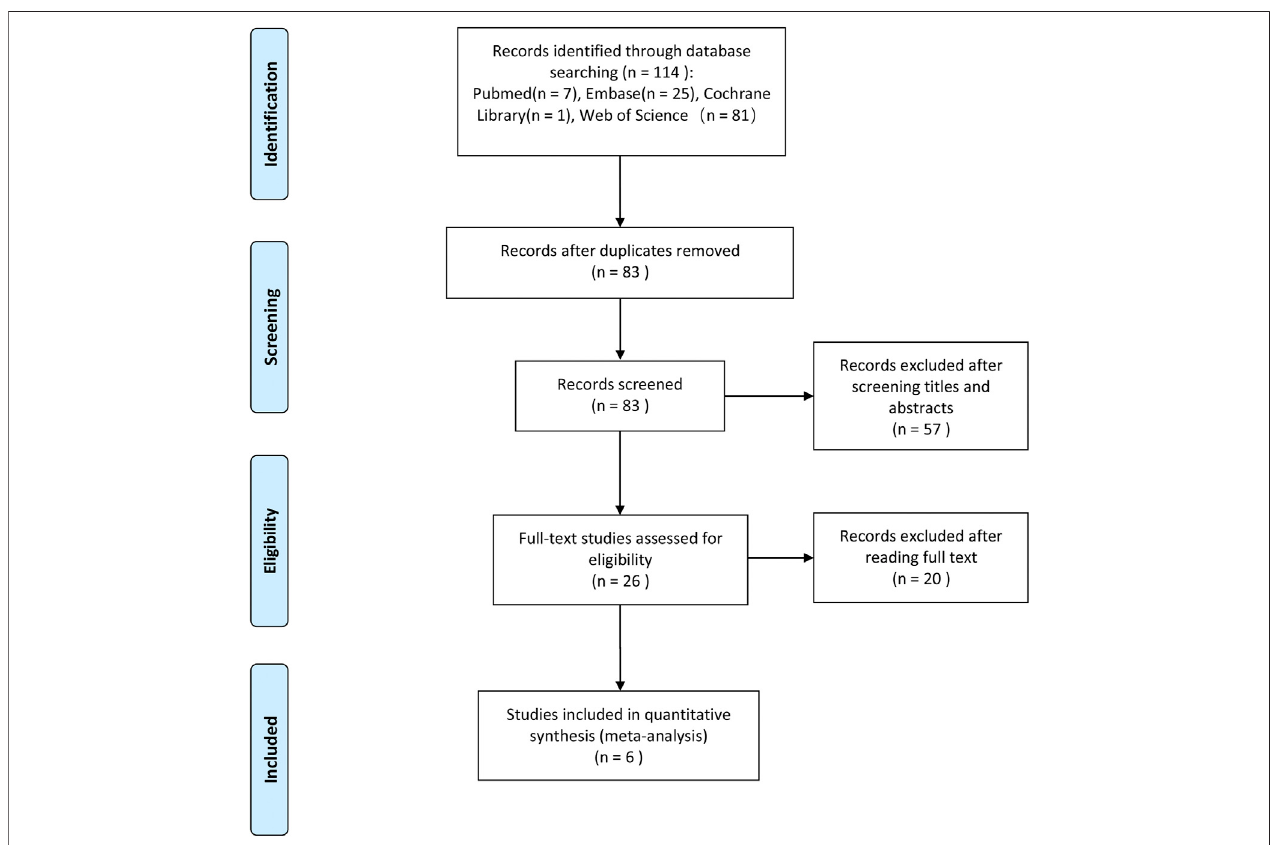
FIGURE 1 | Flow diagram of the literature search process and study inclusion.